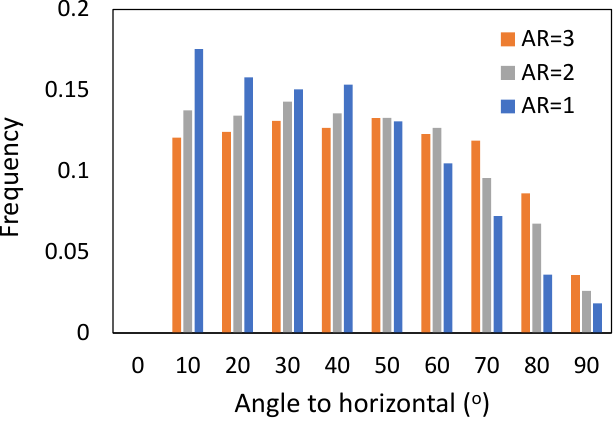
Figure 6. Histogram of vertical orientation of monodisperse cylinders in final packings.